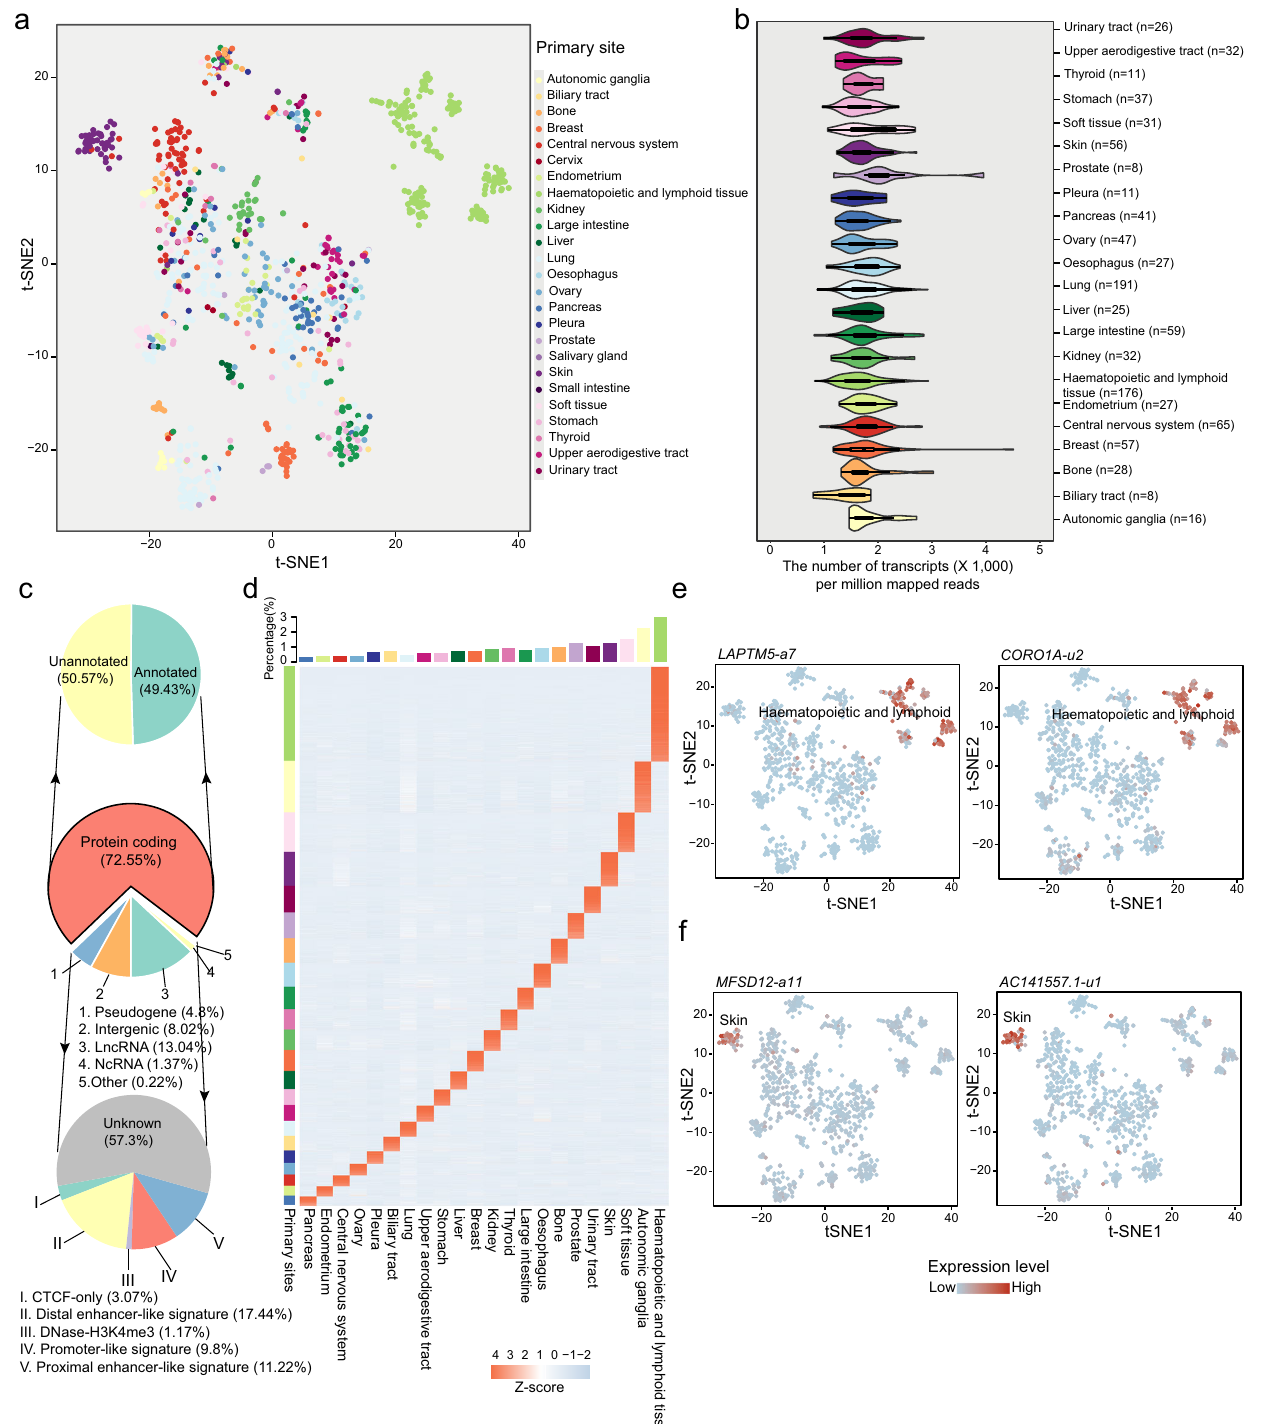
Fig.1|Transcriptionalatlasacrosspan-cancercelllines.a t-SNEclusteringbased on the expression pro fi le of all detected transcripts across all cell lines. b The dis- tribution of normalized transcript numbers across different cell lineages. In each primary site, n is the number of different cell lines. Each box (inset) represents the IQRandmedianofcelllinenumberineachprimarysite,whiskersindicate1.5times theIQR. c Piechartsshowthepercentagesofdistinctgene/genomicregionswhere transcripts are transcribed. The middle pie chart shows different types of genes from which transcripts were derived. The upper pie shows the composition of annotated and unannotated transcripts derived from protein-coding genes. The bottompieshowstheportionsoftranscriptsfromdifferent cis -regulatoryelements